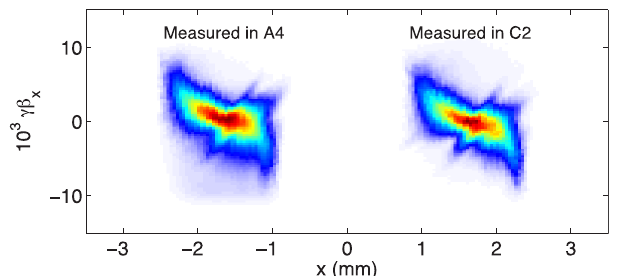
FIG. 6. Comparison of the measured phase space using the A4 and C2 Faraday cups. The 100% emittance in both images is 0.802 and 0 . 785 μ m,